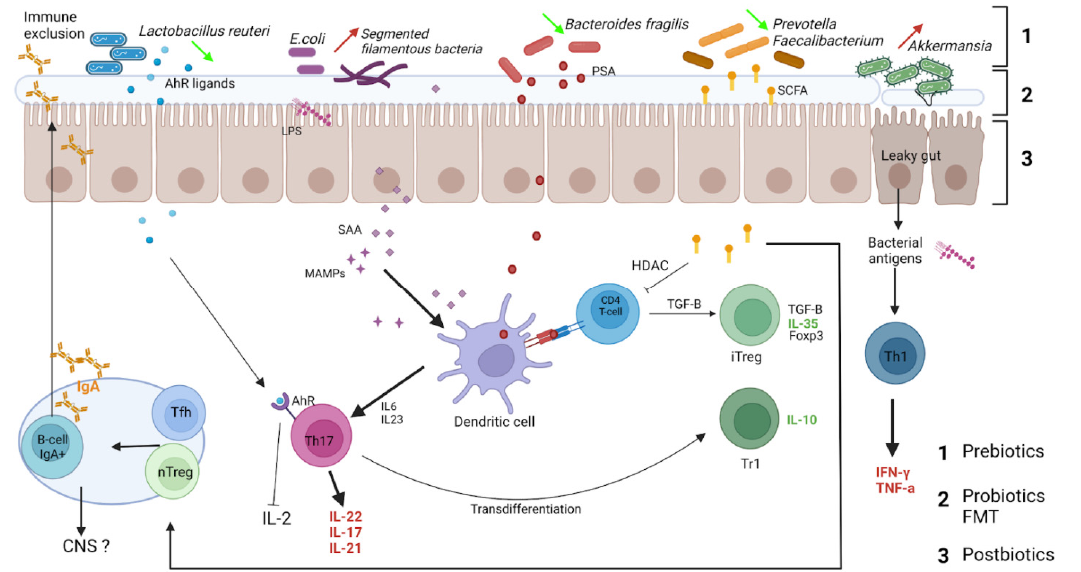
Figure 2. Relevant interactions between microbiota and intestinal immune cells in the context of multiple sclerosis. Gut dysbiosis in MS may participate in the inflammatory environment. Bacteria providing inflammatory signals are increased at the expense of bacteria species harboring regulatory properties. Immune cells arising from the gut can then access extraintestinal tissues